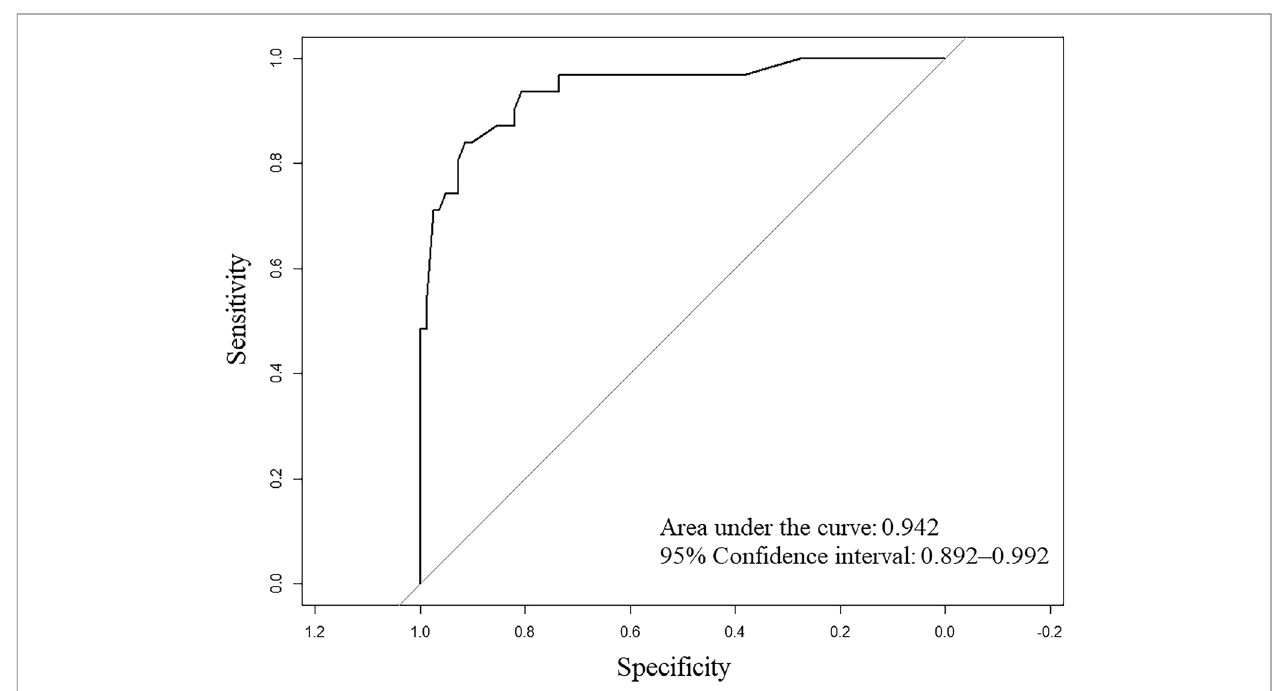
FIGURE 5 | Receiver operating characteristic (ROC) curve for the multivariate predictive nomogram of the pathologic complete response rate after neoadjuvant chemotherapy in breast cancer